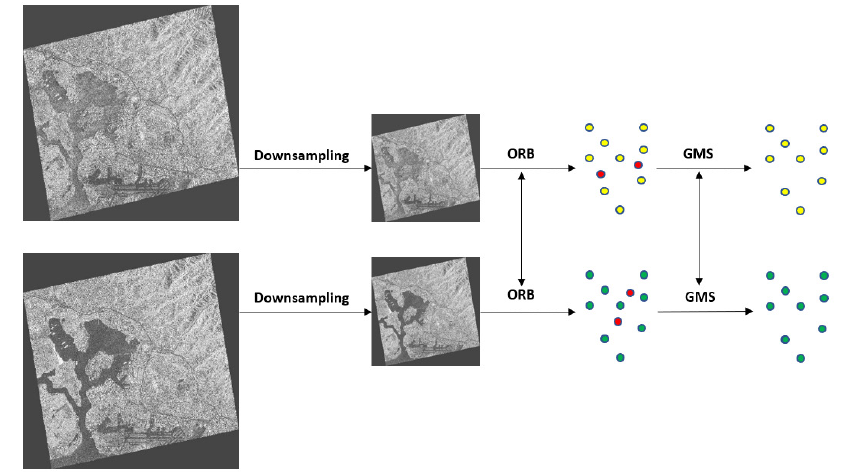
Figure 3. The pipeline of rough matching. 196